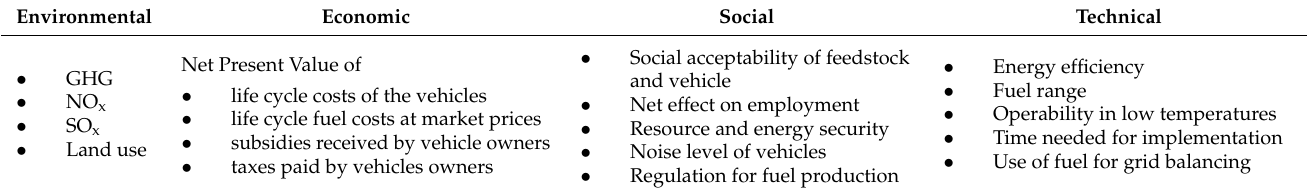
Table 8. Final evaluation criteria by